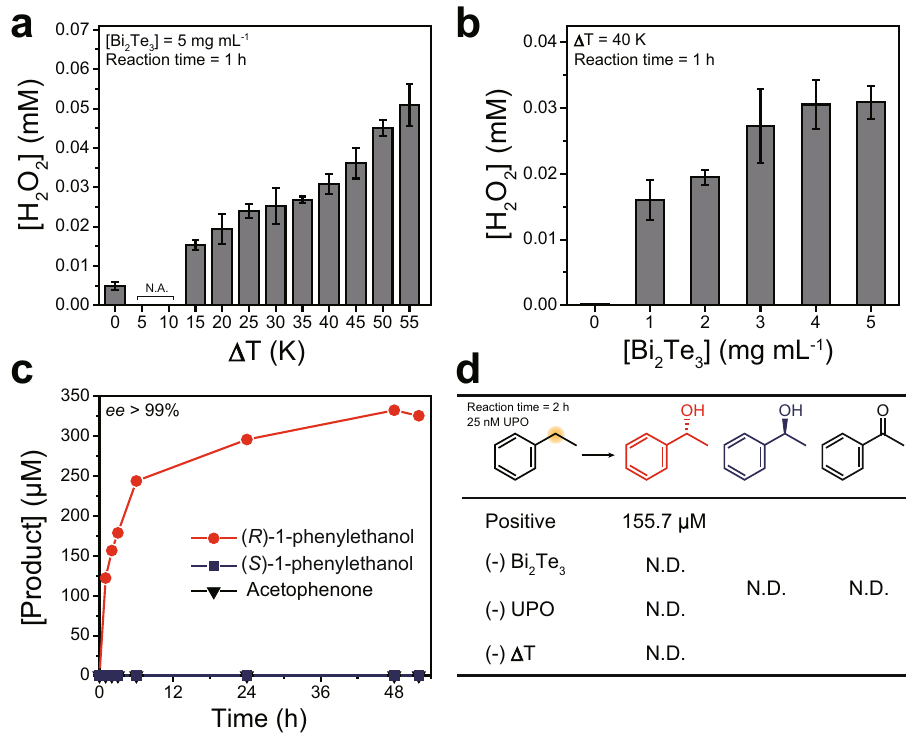
Fig. 3 Thermoelectrocatalytic H 2 O 2 generation and thermoelectrobiocatalytic ethylbenzene hydroxylation using thermoelectric Bi 2 Te 3 particles. a Amount of generated H 2 O 2 with increasing Δ T. Reaction conditions: 5 mg mL − 1 Bi 2 Te 3 dispersed in an O 2 -purged KPB (100 mM, pH 7.0) with applied temperature difference. b Amount of generated H 2 O 2 with increasing concentration of Bi 2 Te 3 . Reaction conditions: Bi 2 Te 3 dispersed in an O 2 -purged KPB (100 mM, pH 7.0) with applied Δ T (45 K). All reported values represent the mean ± standard deviation ( n = 3). c A time course of thermoelectrobiocatalytic conversion of ethylbenzene to ( R )-1-phenylethanol, ( S )-1-phenylethanol, and acetophenone for 50-h reaction. d A series of control experiments for each reaction components for 2-h reaction. Reaction conditions: 5 mg mL − 1 Bi 2 Te 3 , 200 nM r Aae UPO, and 100 mM ethylbenzene dispersed in an O 2 -purged KPB (100 mM, pH 7.0) with applied Δ T (45 K). For control experiments, 25 nM r Aae UPO was used instead. Note that all quantities were determined from gas chromatographic analyses. The negative sign ( − ) denotes that the component is excluded as a control experiment. N.A. not applicable, N.D. not